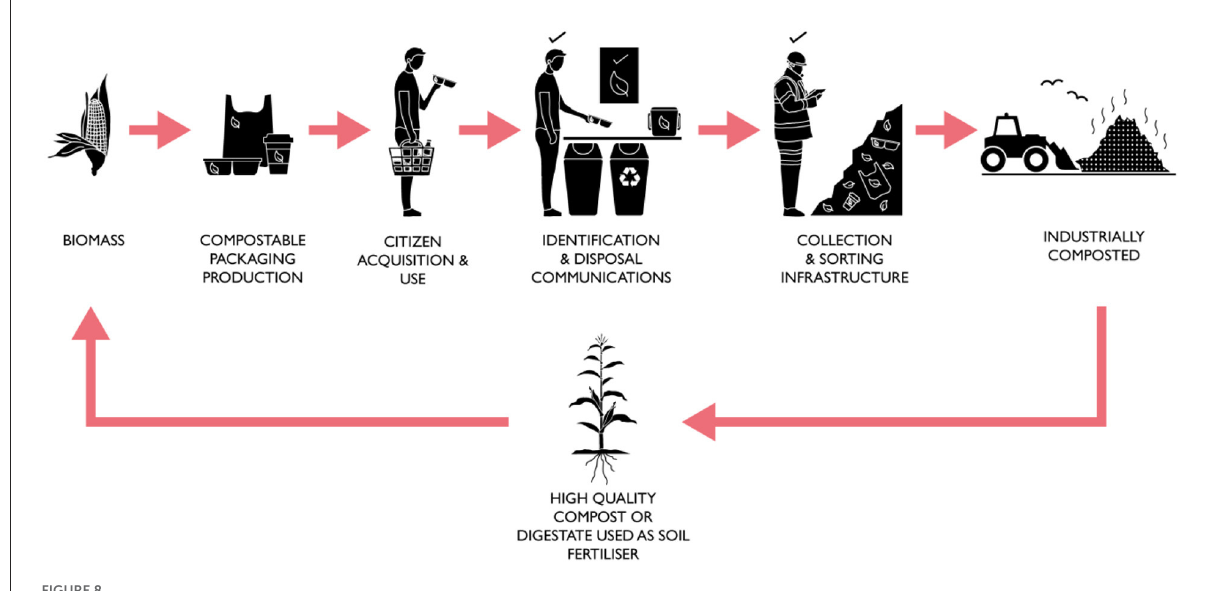
FIGURE8 A circular economy of compostable